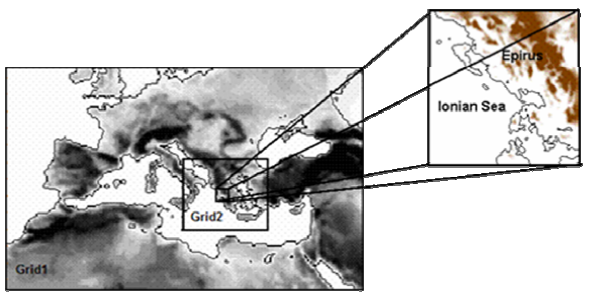
Fig. 1. The three nested domains used.